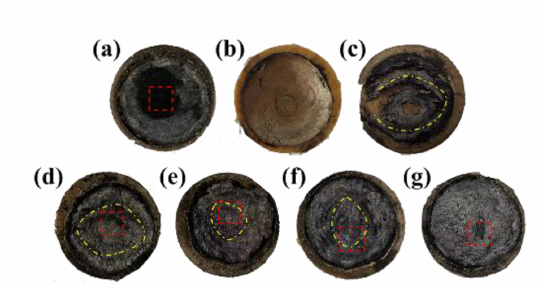
Figure 10. Macroscopic appearance of ablated EPDM composites. (Molded AM ( a ); Molded HM ( b ); (AM/HM) 6 ( c ); (AM/HM) 10 ( d ); (AM/HM) 20 ( e ); (AM/HM) 40 ( f ); (AM/HM) 80 ( g )).